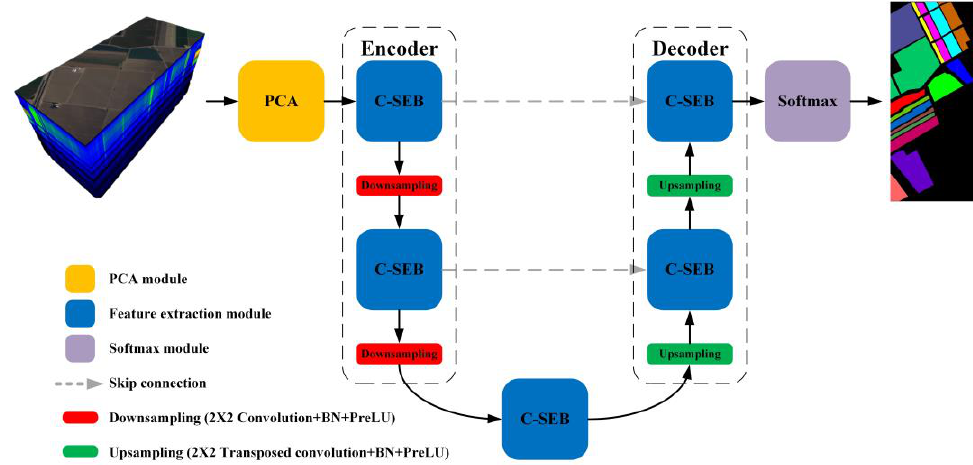
Figure 3. Structure of the proposed PSE-UNet Model.